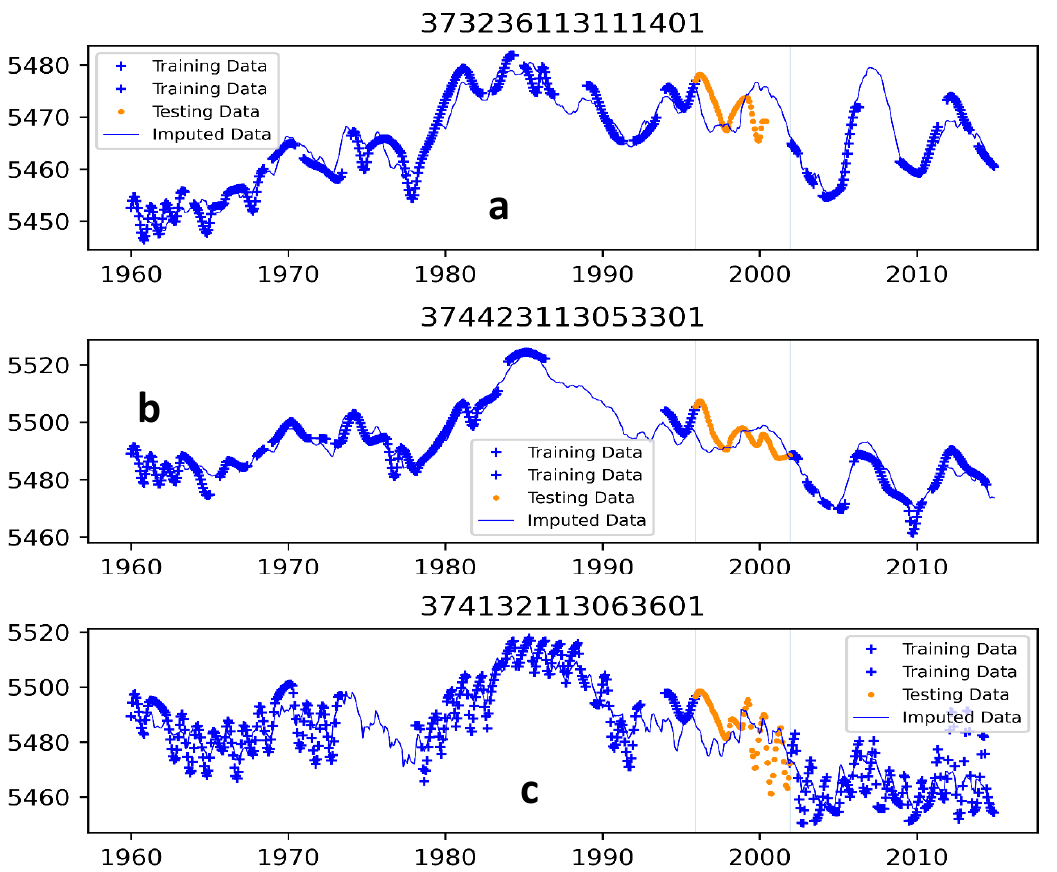
Figure 7. ELM results over a 7 year testing period from 1997–2002 for Wells 37236113111401, 374423113053301, and 374132113063601 as subfigures ( a – c) , respectively. Imputed data are solid blue lines, measured data used for training are blue crosses, and measured data used for testing are orange dots. Table 1. ME, MAPE, RMSE and R 2 values for data imputed using the ELM model for Five Wells in Cedar Valley for both the 2000–2015 and 1995–2002 testing periods. Imputed data were compared to measured data in each period.